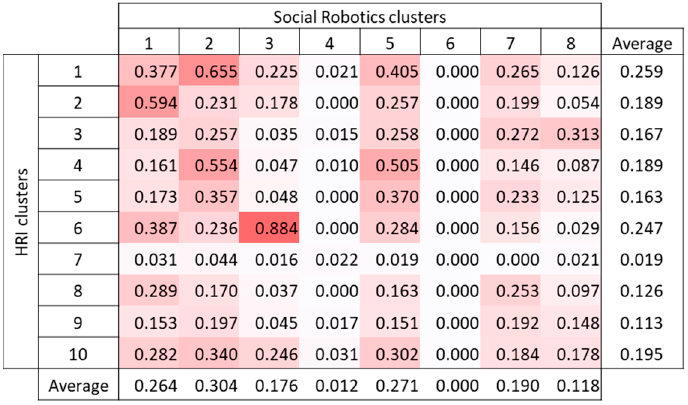
Figure A2. Heatmap analysis based on the cosine similarity of cluster contents. The intensity of red varies according to the similarity score, being 1 a perfect content match between the pair of clusters.